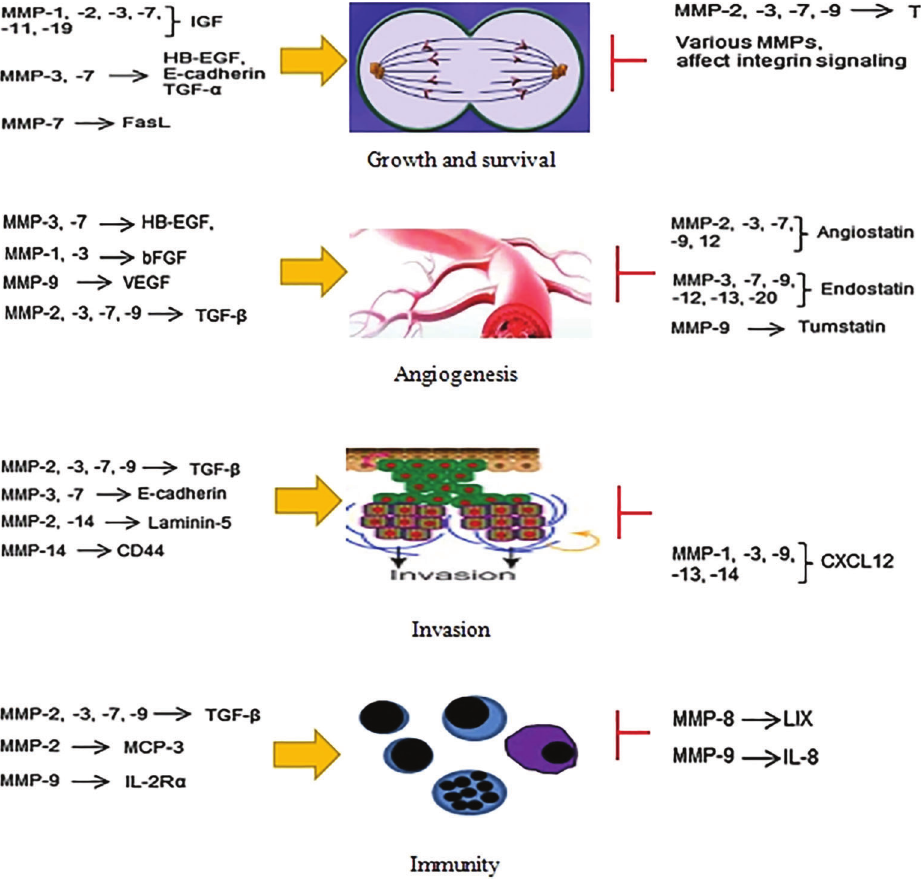
Figure 1. Important effects of matrix metalloproteinases (MMPs) in cancer progression. MMPs play important roles on central aspects of tumor progression, such as tumor growth and survival, angiogenesis, invasion, and modulation of the immune